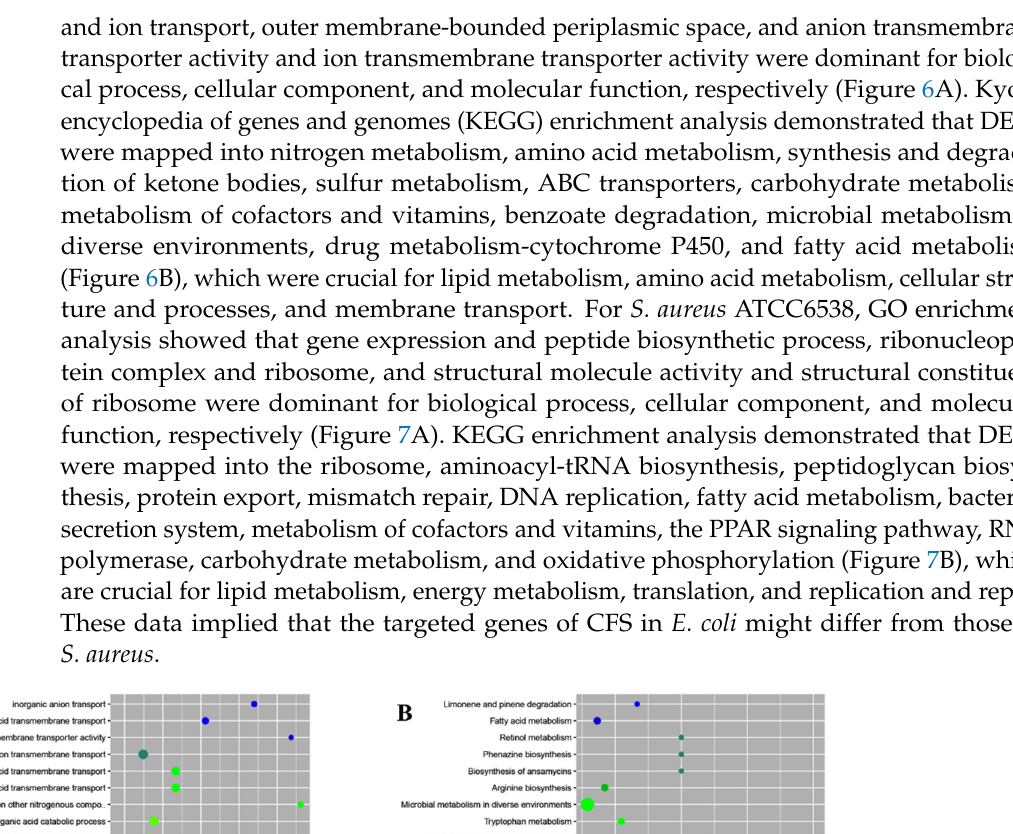
6 of 18 Figure 5. Fold change of selected genes by qRT-PCR after bacterial cells were treated with CFS from L. rhamnosus SCB0119 in E. coli ATCC25922 ( A ) and S. aureus ATCC6538 ( B ). The bacterial 16S rRNA was used as an internal standard. The red line at value 1 represented the expression of chosen genes